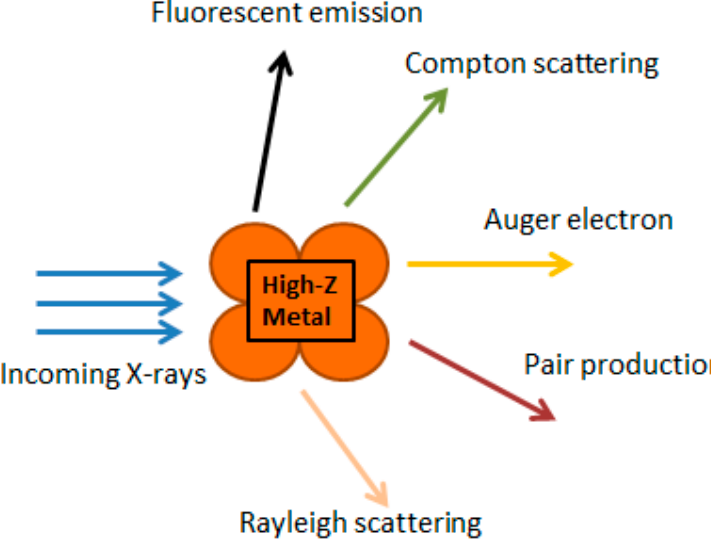
Figure 3. Interaction of X-rays with high-Z material nanoparticles (modified from Reference [49]).